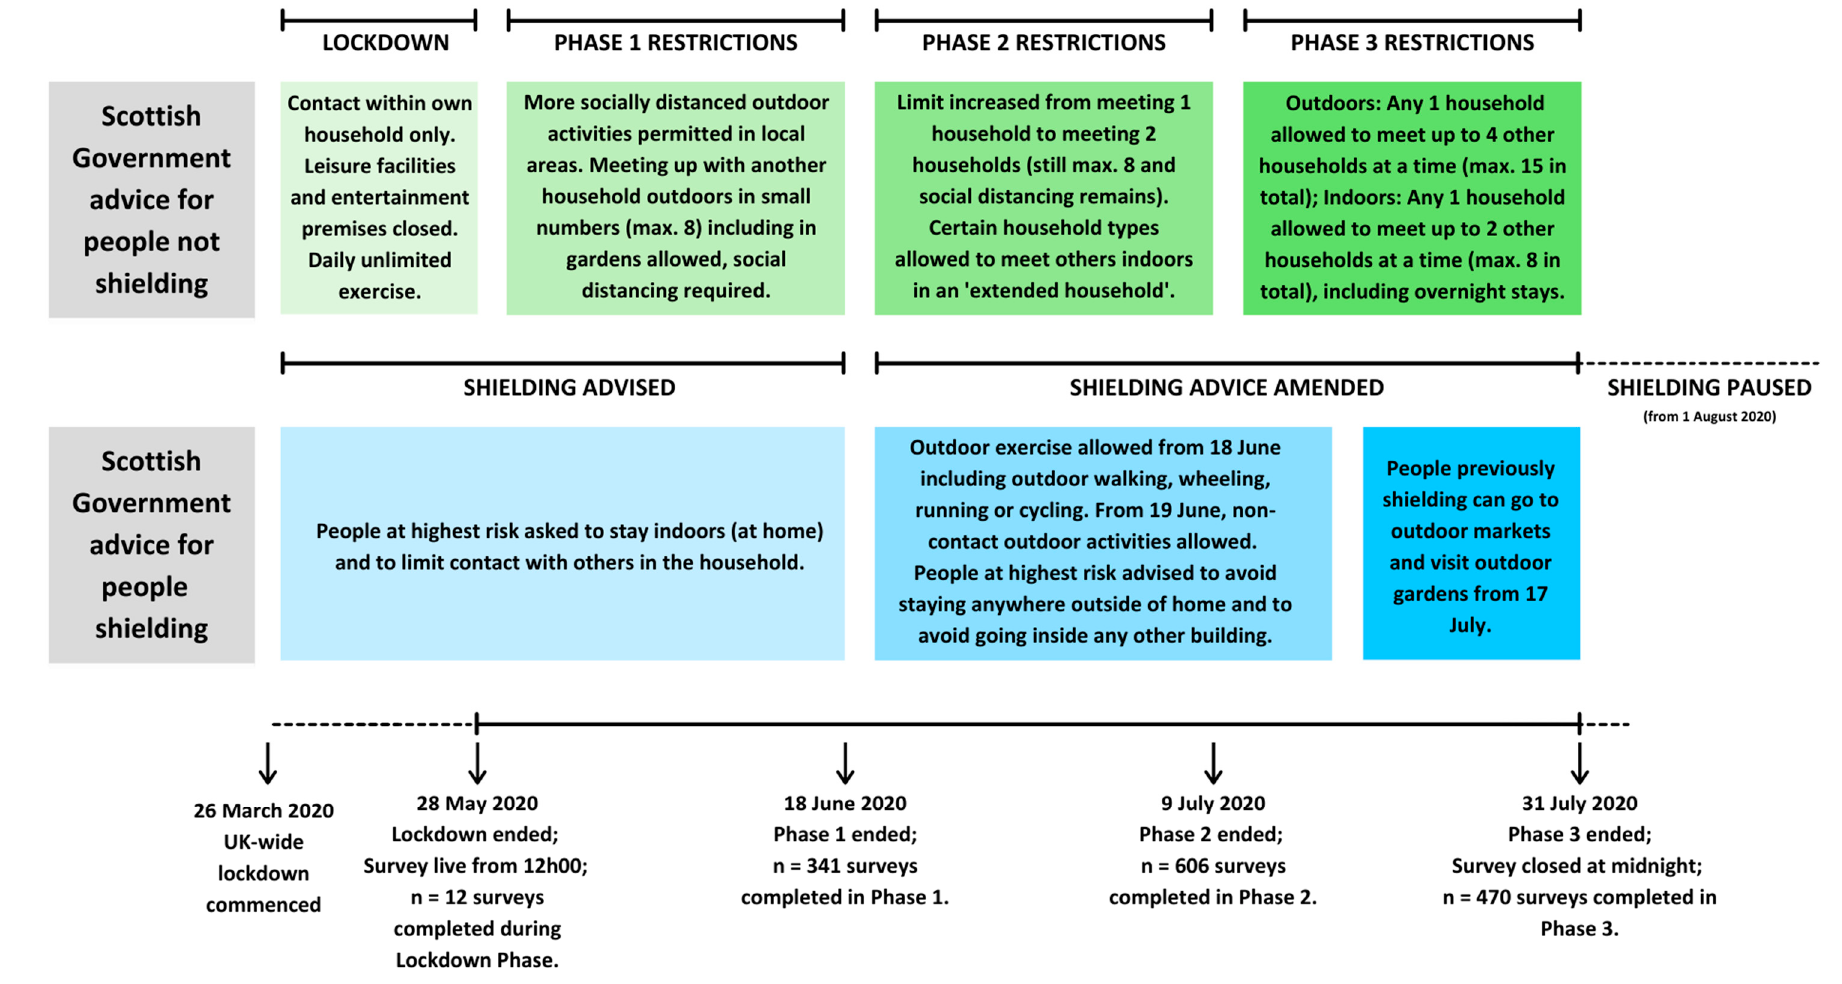
Figure 1. Phases of Scotland’s 2020 lockdown; advice comparison for persons not shielding versus persons shielding in relation to data collection for this study.